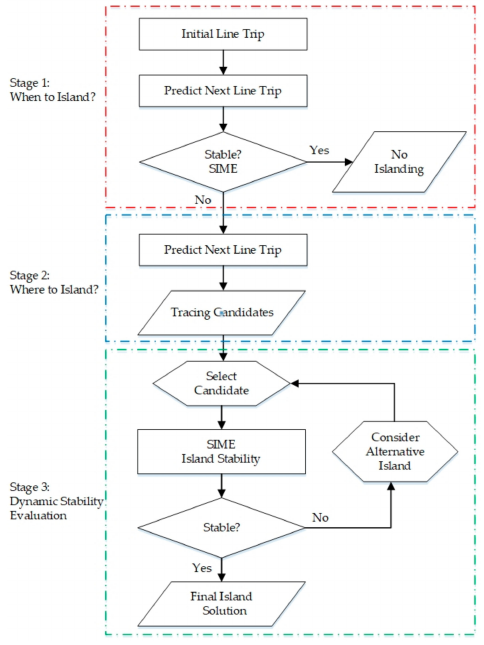
Figure 2. Flowchart of three-stage strategies for controlled